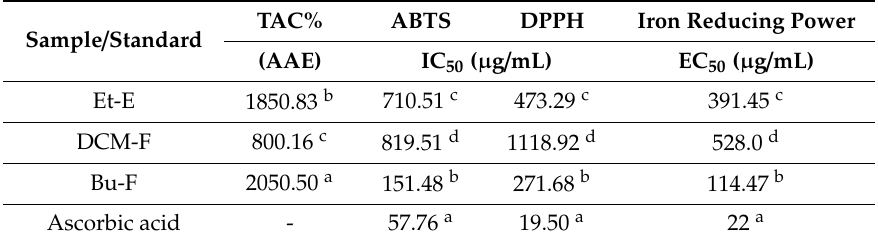
Table 4. Antioxidant activity of Hibiscus